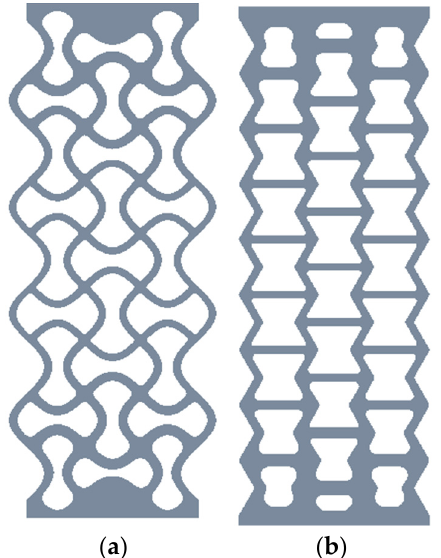
Figure 1. Two examples of cellular structures: ( a ) chiral structure; ( b ) re-entrant structure.